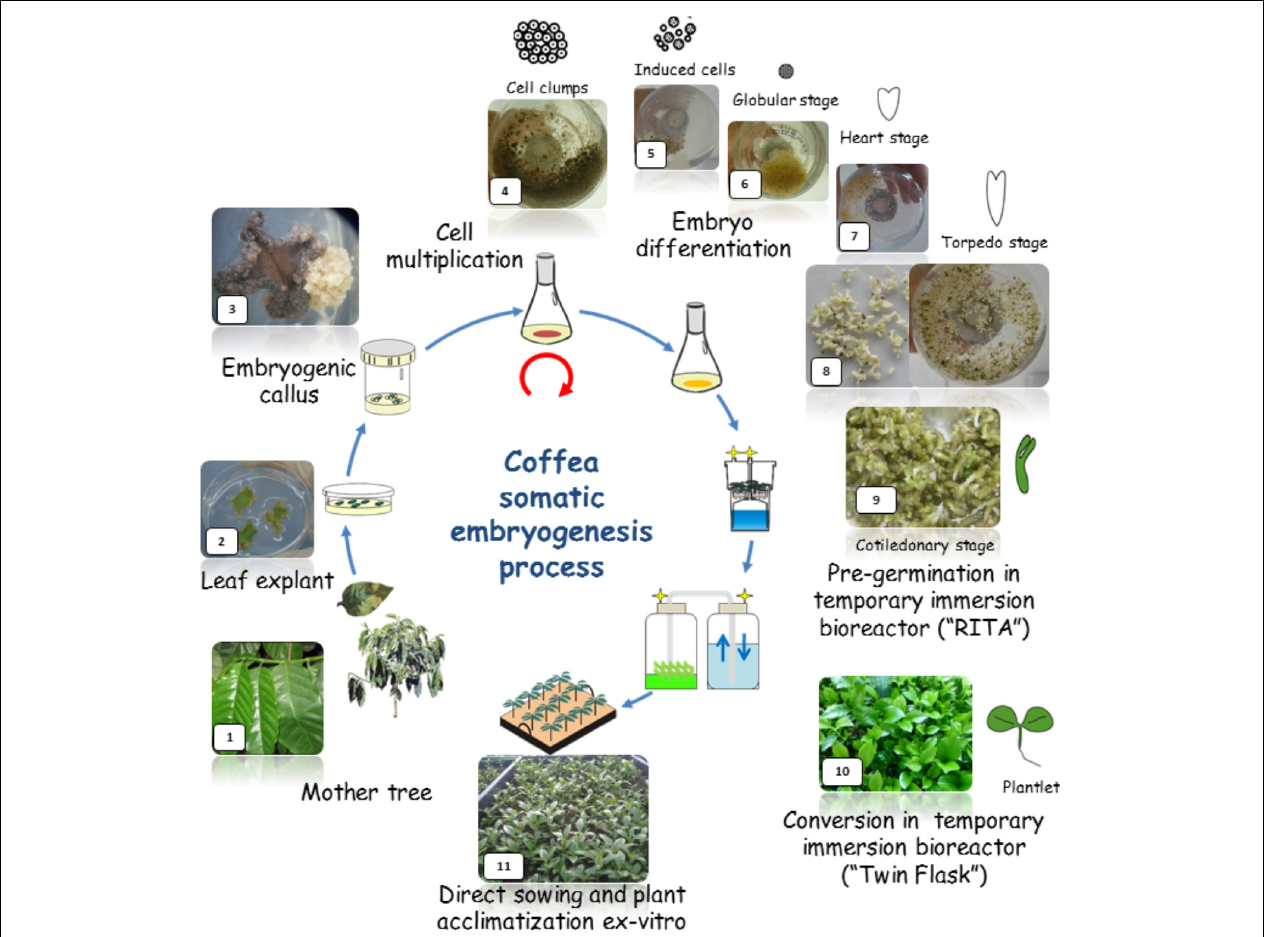
FIGURE 1 | Schematic representation of the Coffea arabica mass propagation process (24 months) through somatic embryogenesis (SE). The process is based on the use of liquid nutritive media for the embryogenic tissue multiplication and embryo regeneration phase and for the pre-germinated embryo and plantlet bulk production in temporary bioreactors (1L-RITA, 5L-MATIS and 3L-Twin-flasks). Direct sowing of germinated embryos and plantlets onto horticultural substrate avoids the use of gel media and requires less manpower in in vitro